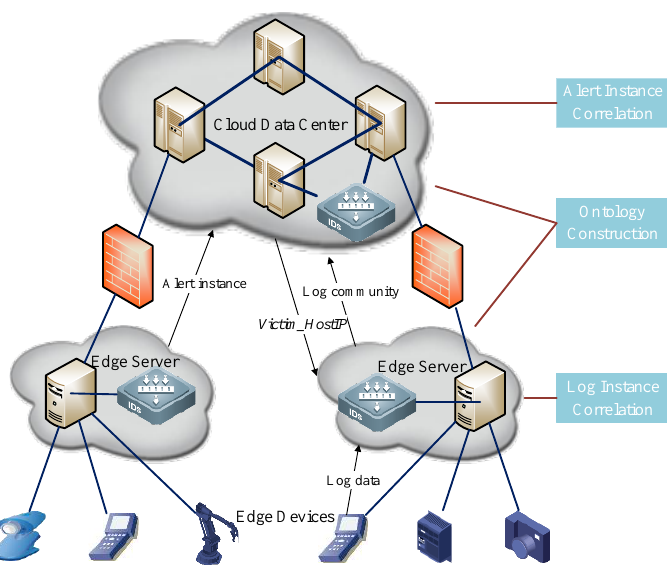
Figure 2. The architecture of APTALCM.